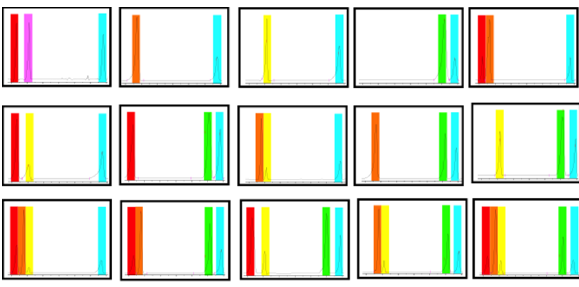
Figure 5. Barcoding agrochemical products with a library of barcodes formed by five types of organic solid